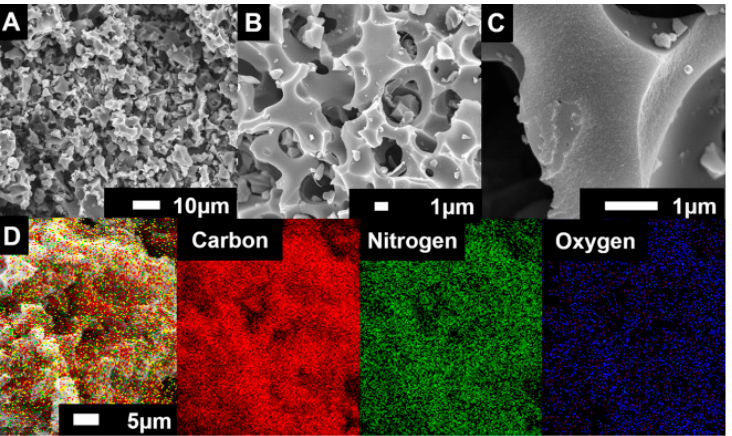
Figure 6. ( A − C ) Macro/micropole-dominated carbon on SEM (scanning electron microscope) images with different scale (10 μ m and 1 μ m) and ( D ) element mapping of highly porous activated carbon [47]. Reprinted with permission from Ref. [47]. Copyright 2017 American Chemical Society.